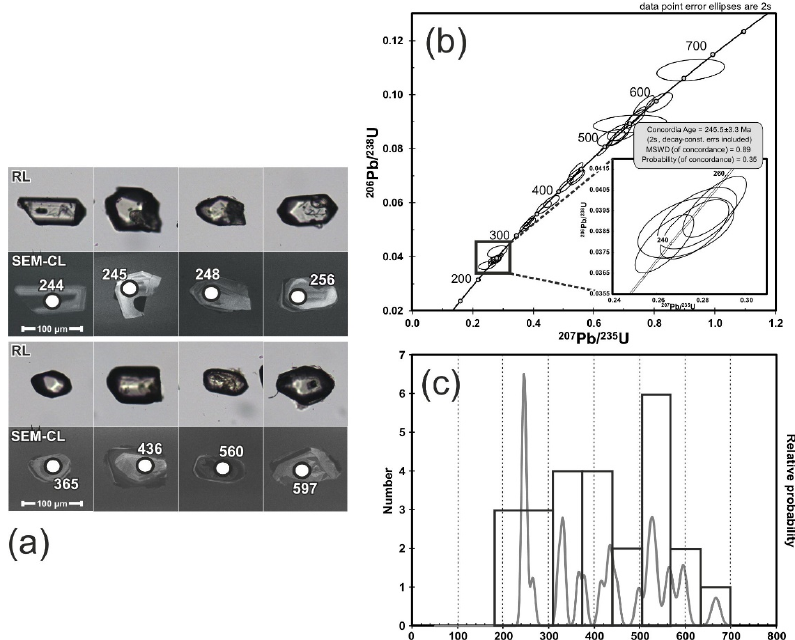
Figure 17. ( a ) Examples of zircon reflected light (RL) and SEM cathode-luminescent (SEM-CL) images from metabasalt s. DOL-1 in the Dobšin á quarry with dated spots. ( b ) Zircon U–Pb SIMS age diagram. ( c ) Relative probability and age histograms from s.